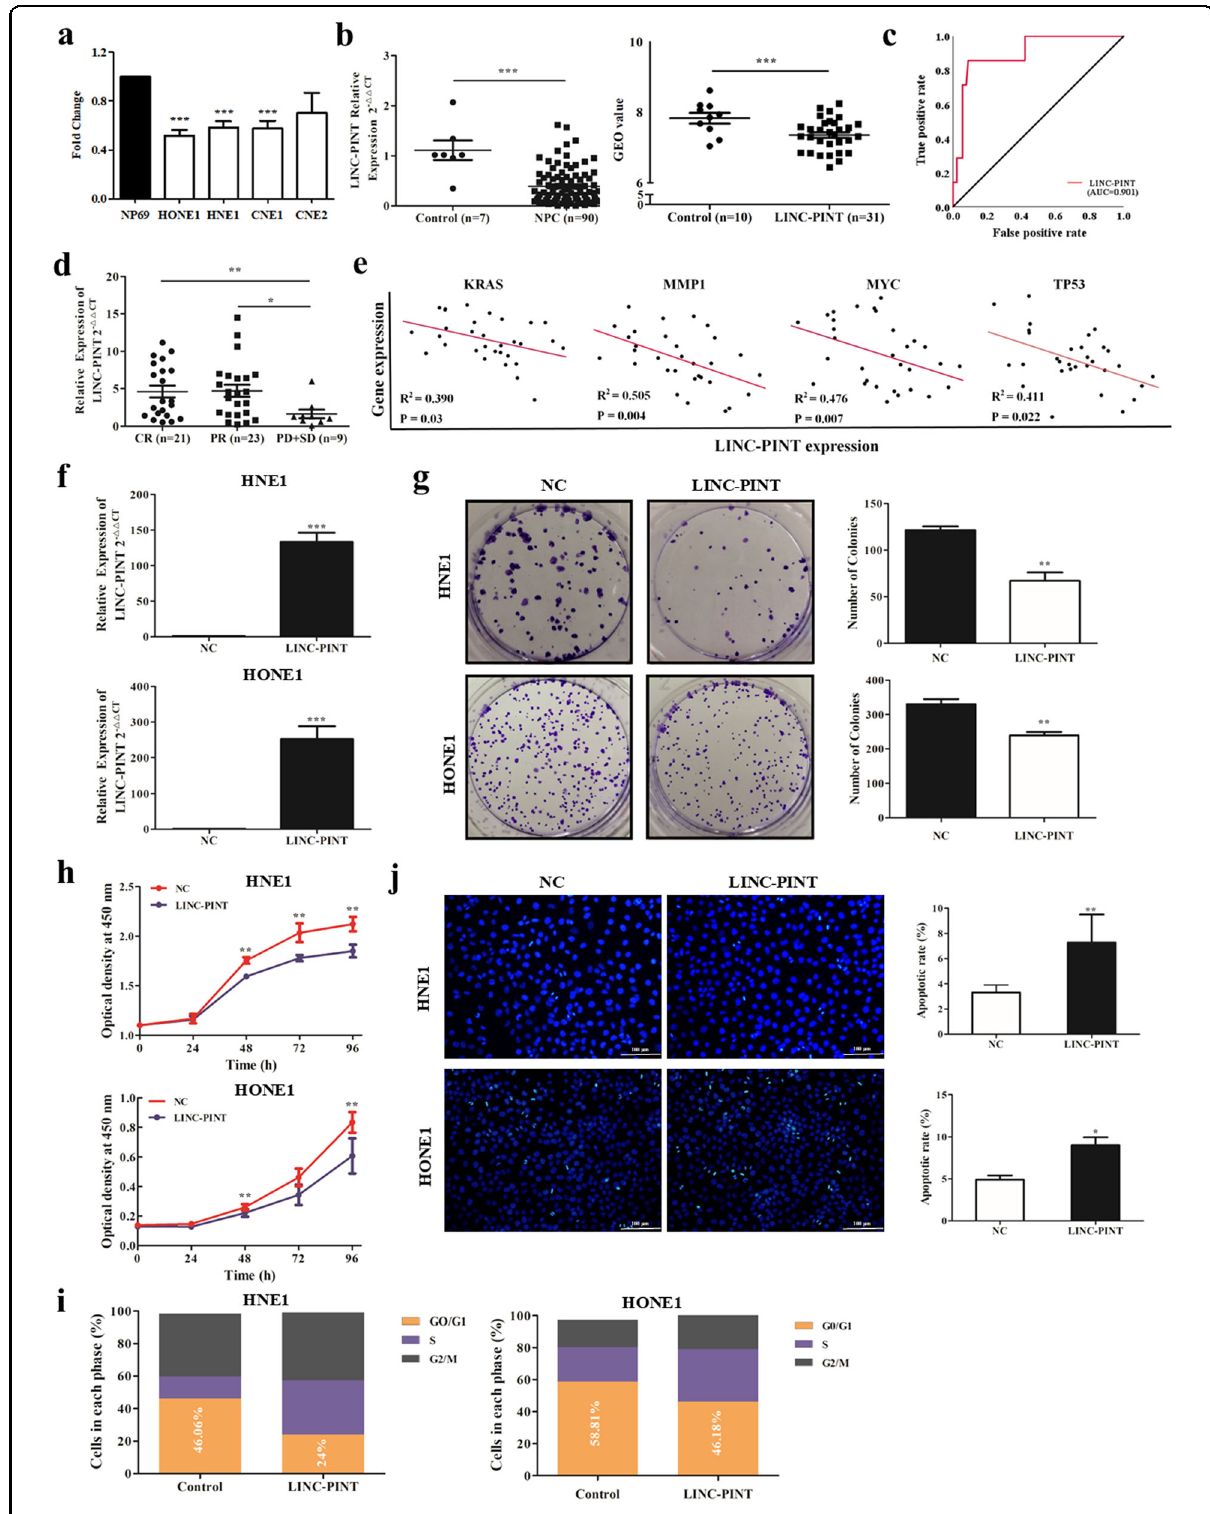
Fig. 1 (See legend on next